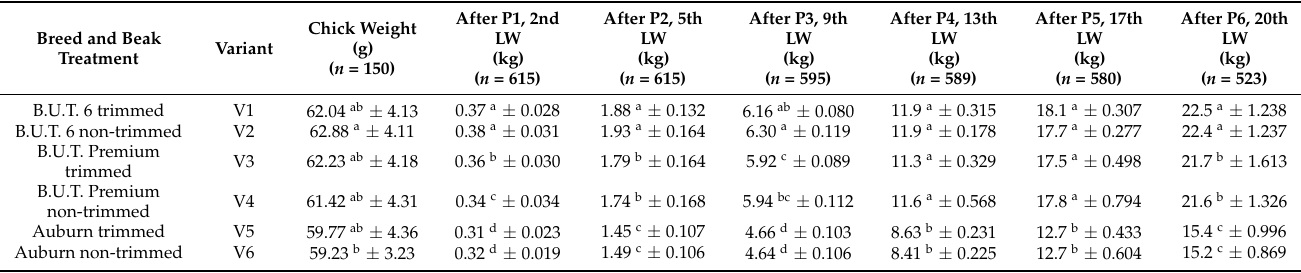
Table 2. Average live weight and standard deviation ( ± ) of male turkeys in grams (chick weight) and kilograms (all others) in relation to the variant, phase, and week of